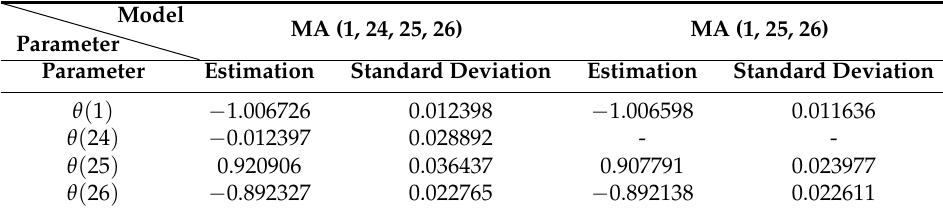
Table 12. Parameter estimation results of MA (1, 24, 25, 26) and MA (1, 25, 26). ParameterModel